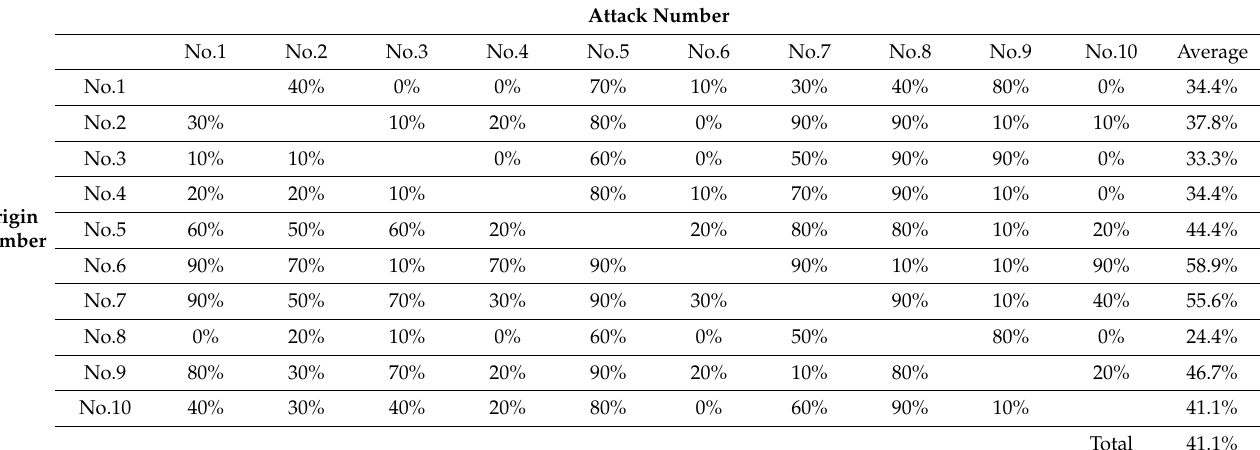
Table 18. Impersonation defense rate after